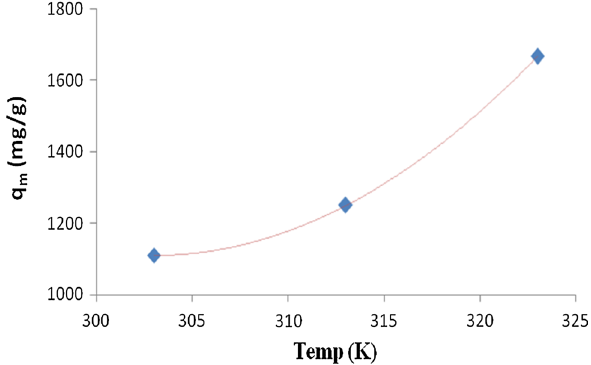
Fig. 8 Effect of temperature on the adsorption of Rh-B dye onto